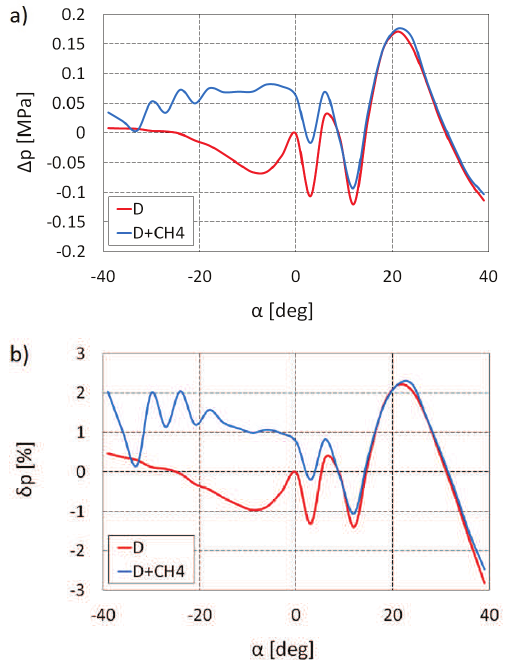
Fig. 5. Absolute (a) and relative (b) errors of the accuracy of the estimation of measured in-cylinder pressure by the model for two cases of engine supply with diesel oil – D and with a mixture of diesel oil and 30% (w/w) of methane – D +